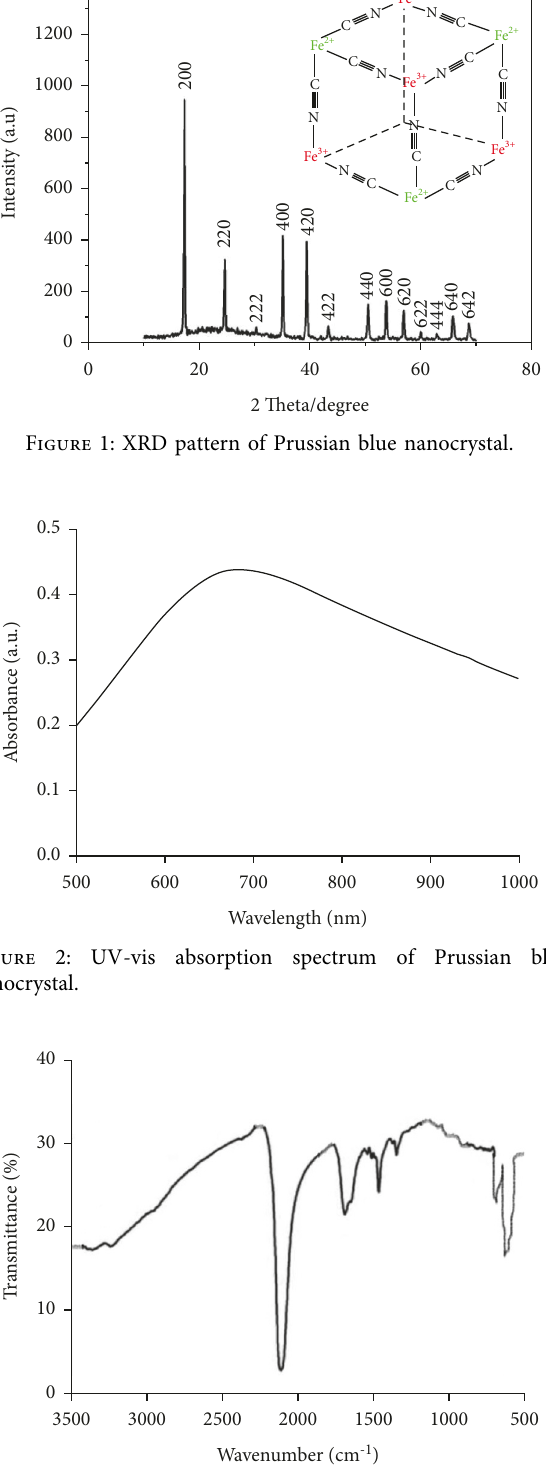
Figure 3: FTIR spectrum of Prussian blue